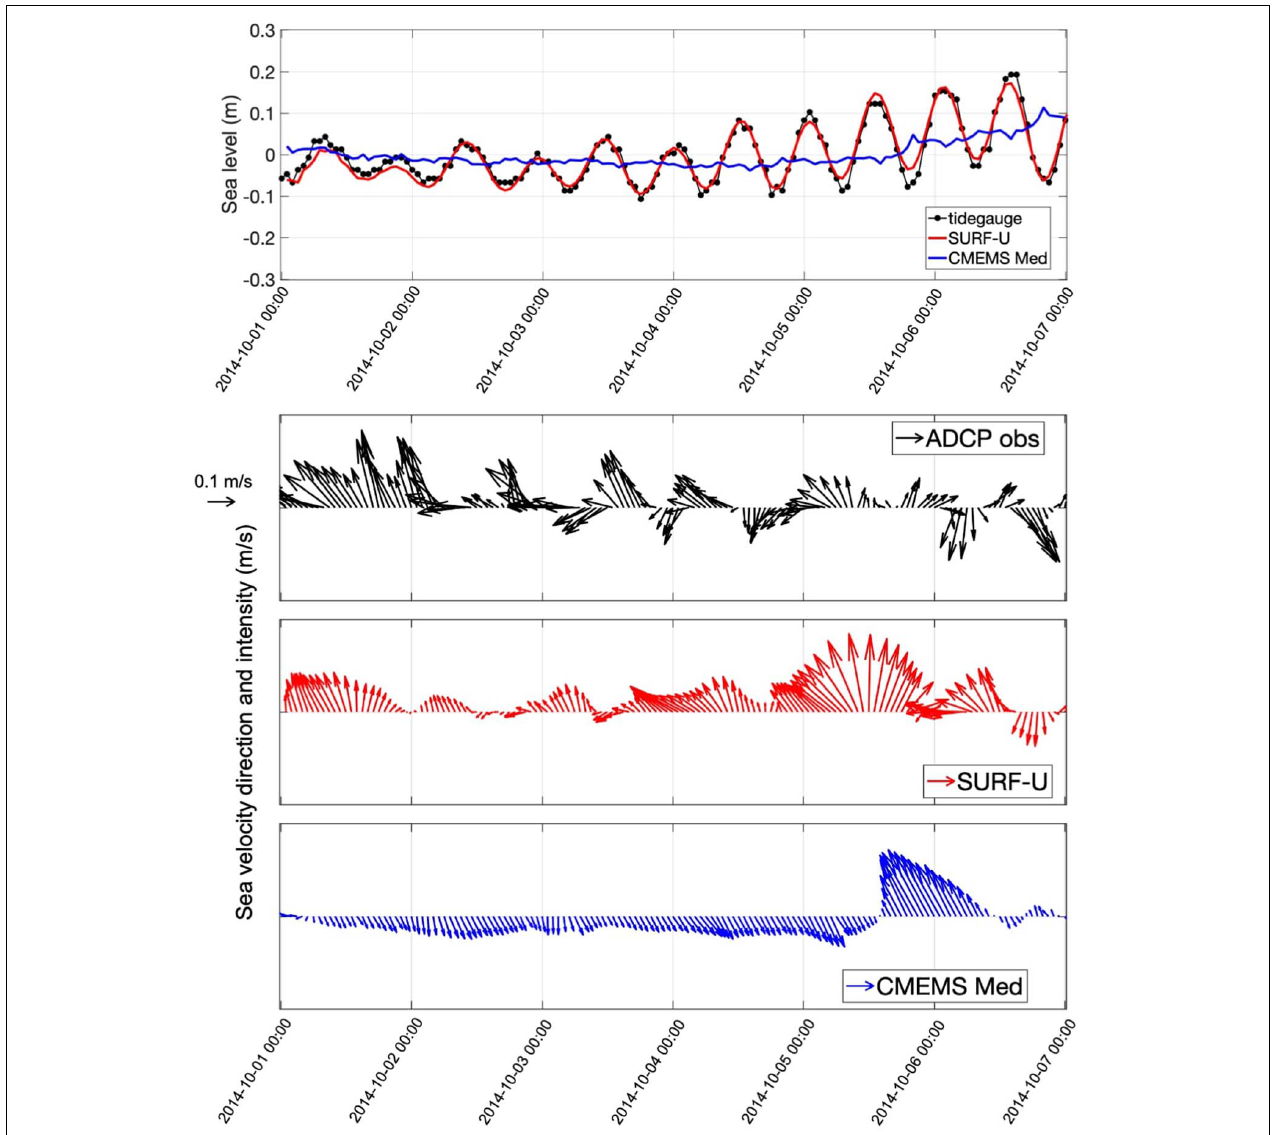
FIGURE 4 | A comparison between modeled (SURF-U and CMEMS MED) and measured sea levels from tide-gauge (top panel). Time series of sea velocity direction and intensity, as measured by ADCP (black rows) and modeled by SURF-U (red rows) and by CMEMS Med (blue rows) (bottom panel) are given. The locations of the tide-gauge and ADCP stations are reported in Figure 2 right